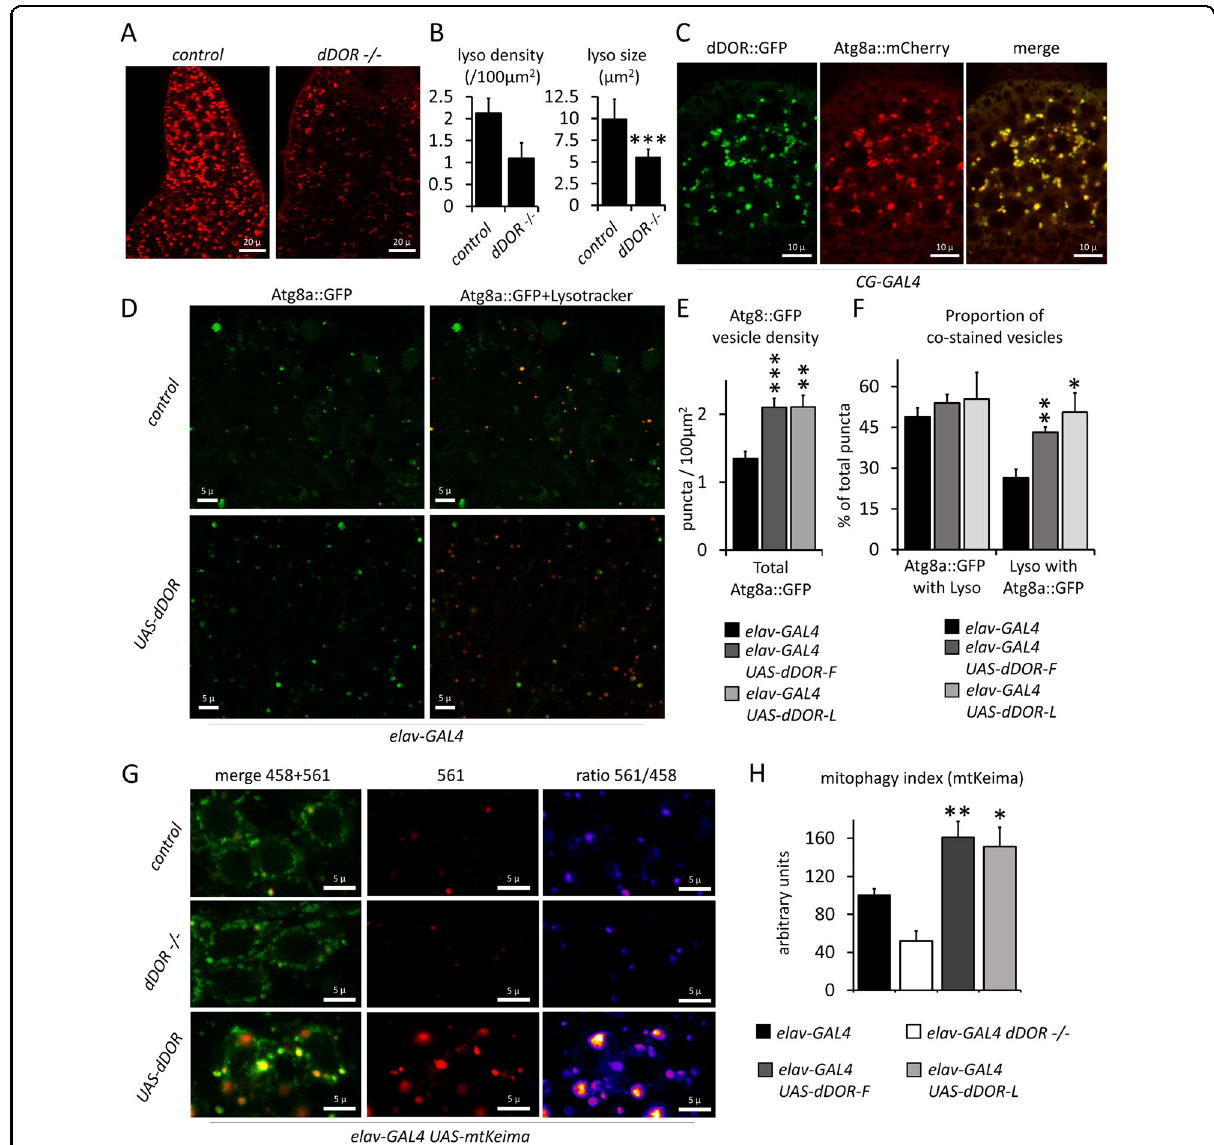
Fig. 5 TP53INP1 Drosophila homolog dDOR activates autophagy and mitophagy. A Confocal images of living third instar larvae fat bodies from control ( w 1118 ) and dDOR homozygous null mutant ( − / − ) stained with Lysotracker. B Quanti fi cation of lysosome density (lysotracker positive puncta per 100 µm 2 ) (left panel) and quanti fi cation of average lysosomal size (µm ± SD) in control and dDOR homozygous mutant fat bodies. Three samples analyzed for each condition. Mann – Whitney U test result: *** P < 0.001. C Confocal images of living fat bodies from CG-GAL4 UAS-mCherry::Atg8a UAS- dDOR::GFP third instar larvae. D Confocal images of elav-GAL4 UAS-Atg8a::GFP living adult fl y brains (10-day old females at 29 °C) stained with lysotracker and expressing or not a UAS-dDOR-F transgene. E Quanti fi cation of Atg8a::GFP positive vesicles (puncta per 100 µm 2 ± SEM) in brains of elav-GAL4 UAS-Atga::GFP adult fl ies expressing or not a UAS-dDOR transgenes (dDOR-F but not dDOR-L contains EcR binding motif). Number of analyzed samples: 20 for elav-GAL4 control, 14 for elav-GAL4 UAS-dDOR-F , 8 for elav-GAL4 UAS-dDOR-L . Mann – Whitney U test results: *** P < 0.001, ** P < 0.001. F Proportion of Atg8::GFP puncta co-stained with Lysotracker (% ±SEM) and proportion of Lysotracker positive puncta co-stained with Atg8a:: GFP in fl ies expressing or not UAS-dDOR transgenes. Number of analyzed samples: 20 for elav-GAL4 control, 14 for elav-GAL4 UAS-dDOR-F , 8 for